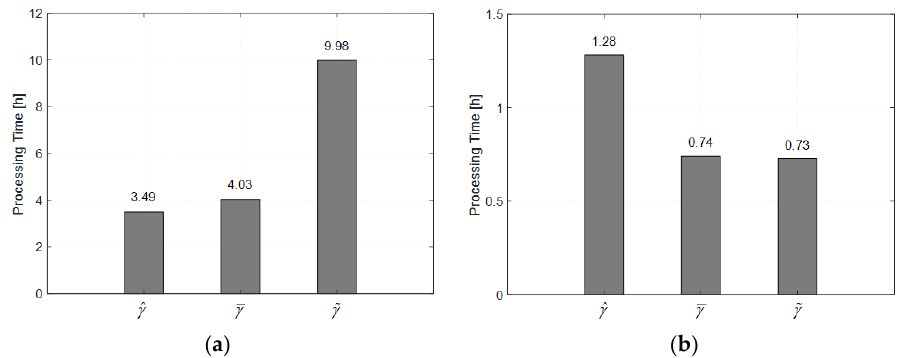
Figure 15. Processing time over: ( a ) the coherence matrix estimation; ( b ) the EMI phase optimiza- tion.